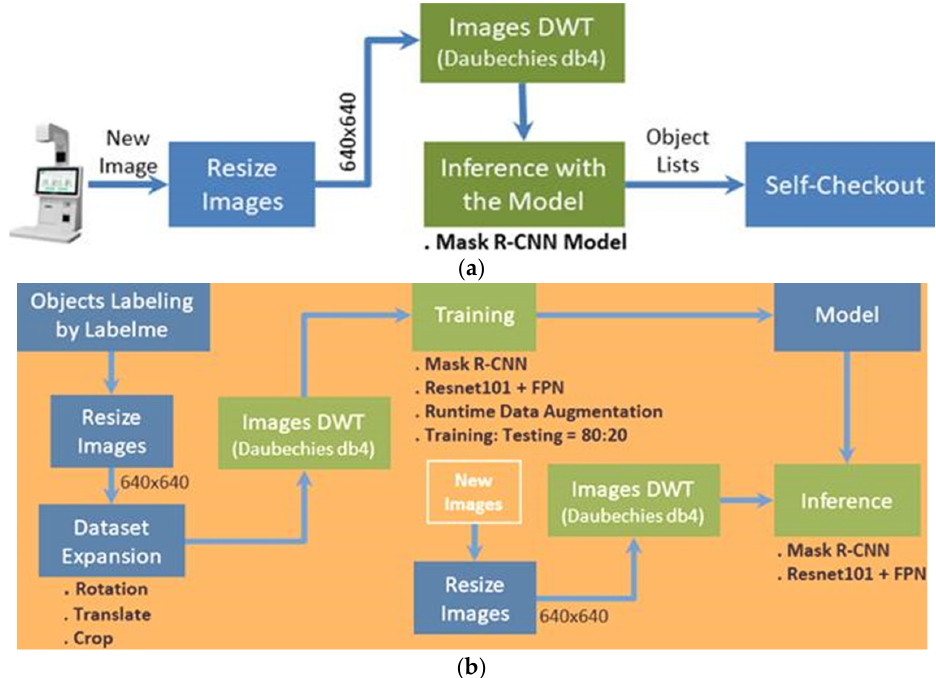
Figure 3. Flowchart for the proposed architecture. ( a ) Flowchart of inference model and ( b ) flowchart of the training and inference model.